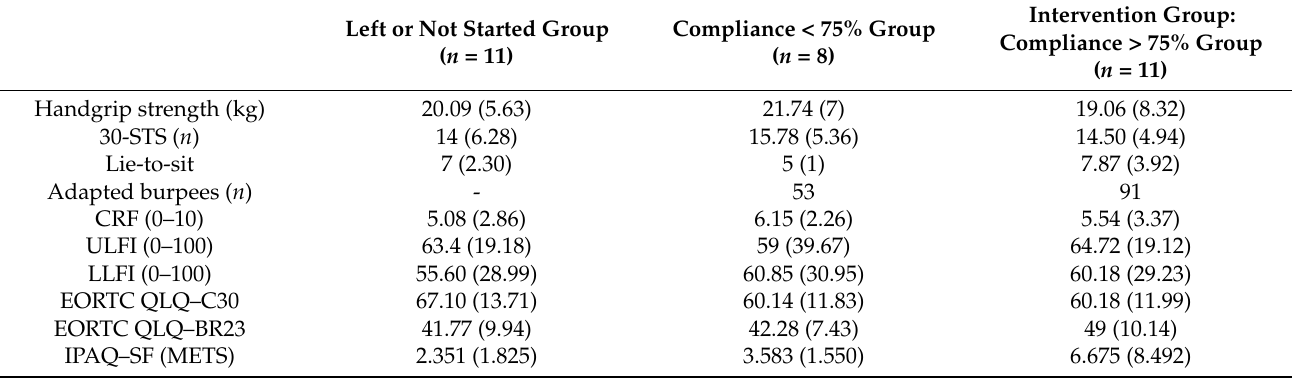
Table 3. Patients’ baseline functional and self-reported outcomes in each attendance group.